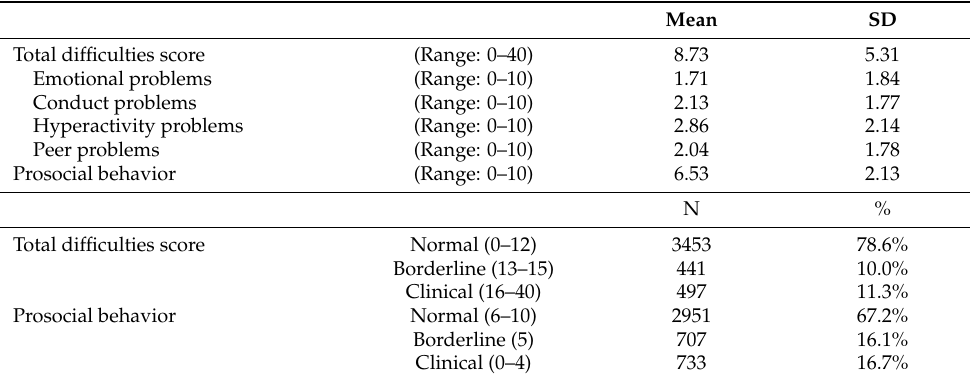
Child emotional and behavioral problems from parent-reported Strength and Difficulties